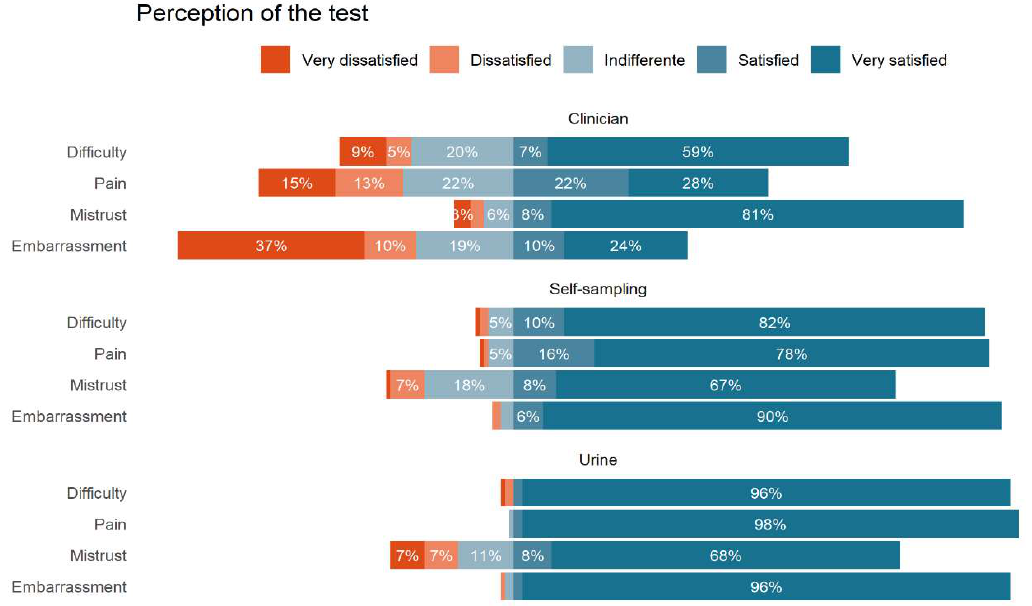
Figure 2. Individual perception of acceptability.